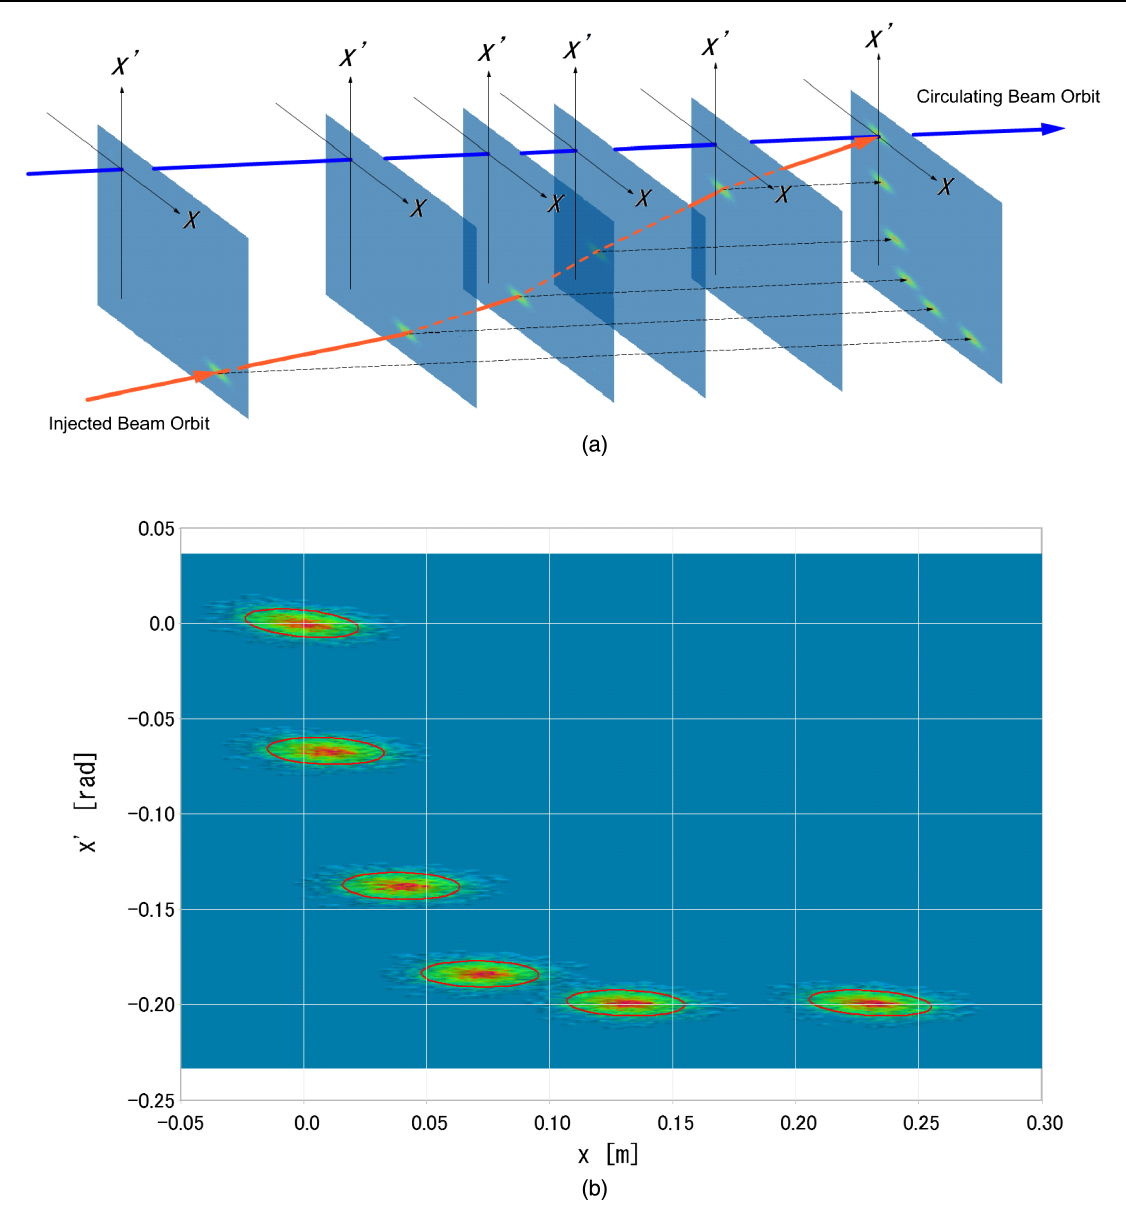
FIG. 17. (a) Horizontal phase space configuration. (b) Beam excursion in the horizontal phase space, whose origin is the circulating beam orbit, for the Model 0. The solid red line is the Courant-Snyder ellipse with 2 (cid:2)